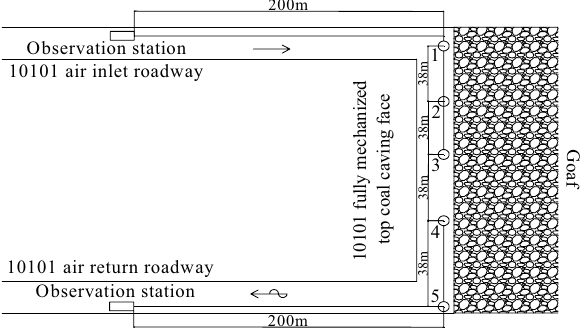
Figure 1. Layout of beam tube and temperature